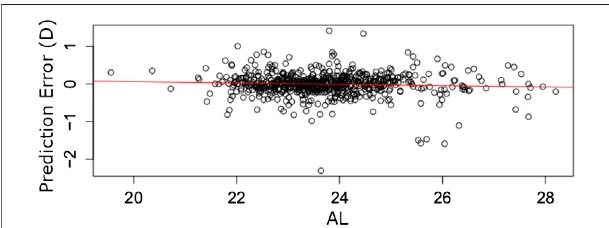
FIGURE 3 | Prediction errors ( y -axis) for 1,000 eyes out-of-sample arranged by AL ( x -axis). The red line fi ts a linear error trend. The slope of zero implies the BART model ’ s errors are likely independent of AL.